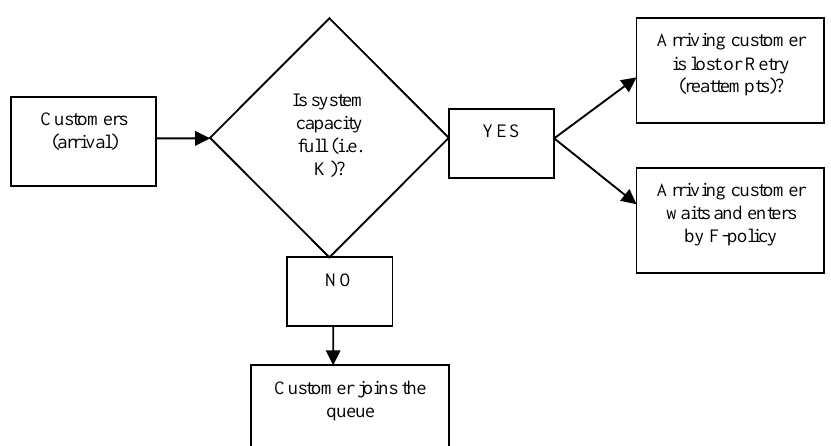
Figure 2. Schematic diagram for automobile repair shop (ARS)